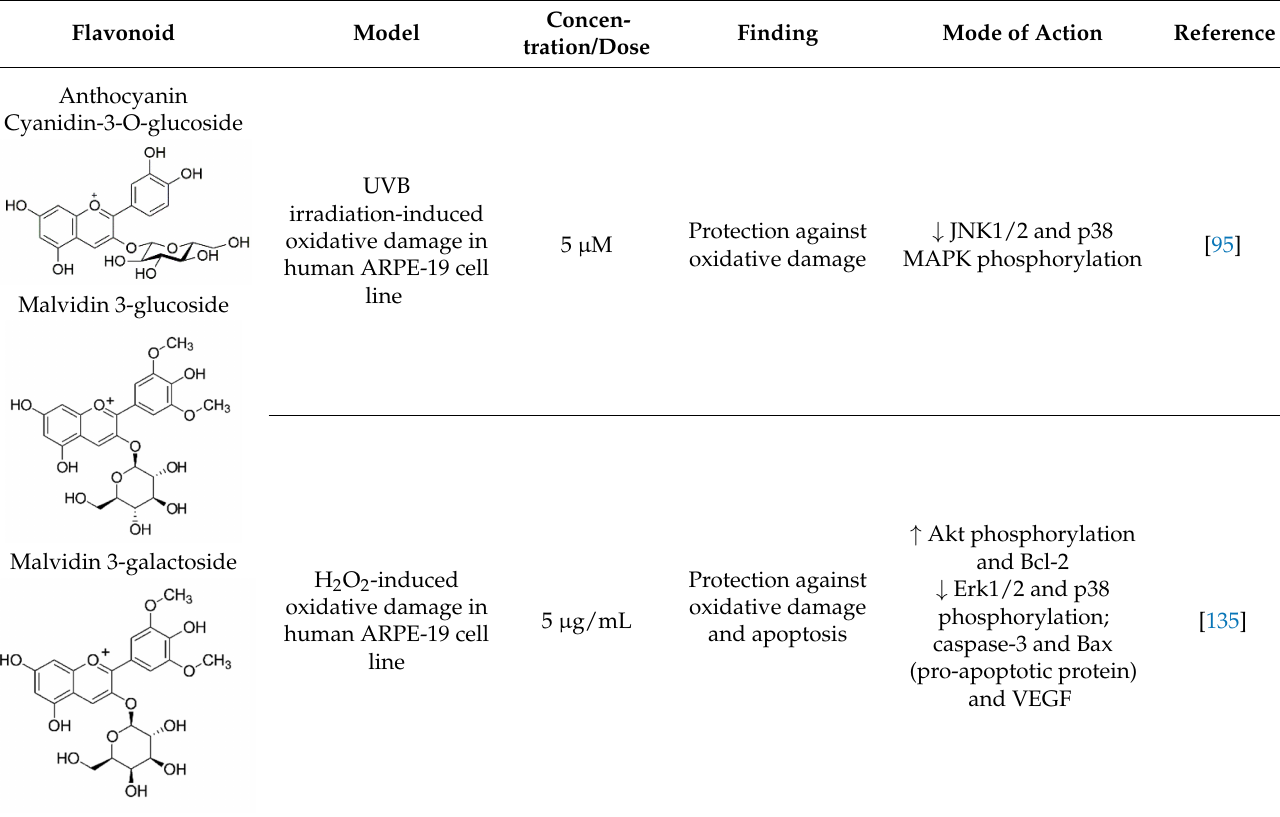
Table 4. Flavonoids in the alleviation of